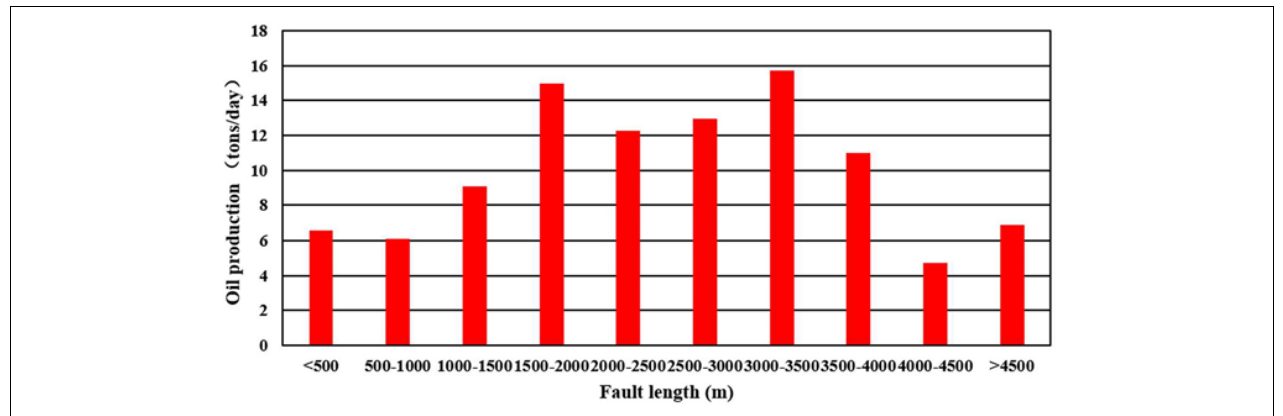
FIGURE 10 | The oil production in the wells drilled different length of